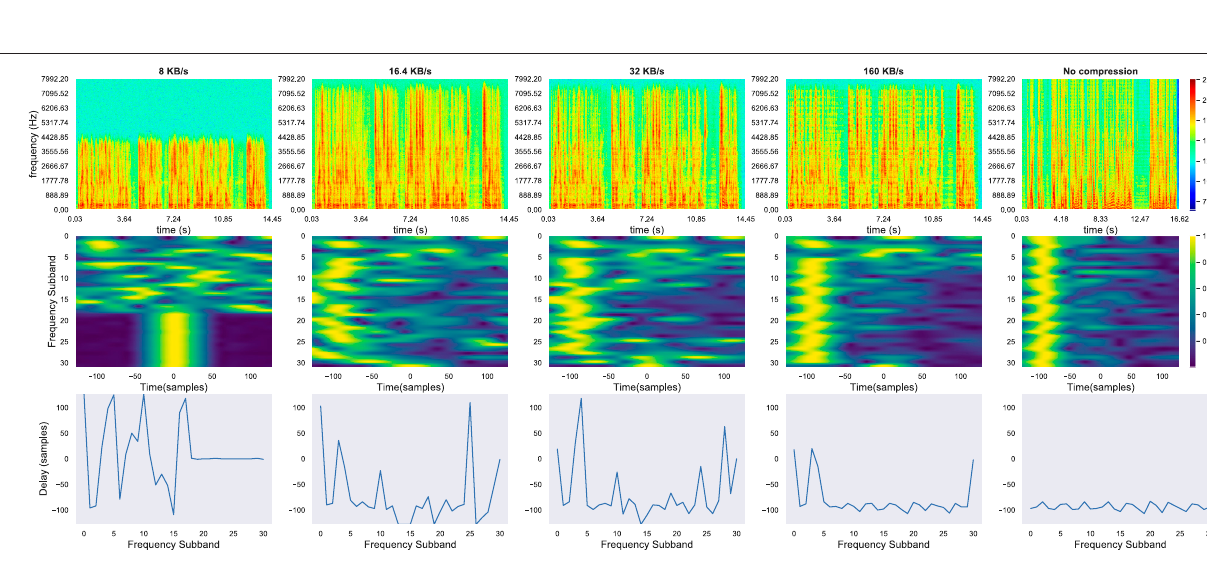
FIGURE 10 | 1 st row: Spectrograms for one uncompressed test utterance channel and its Opus-encoded versions at various bitrates [160, 32, 16.4, 8]kB/s. 2 nd row:Frequency-slidedCPSinputfeaturecomputedbetweentwosegmentsoftheencodedchannels.3 rd row:argumentofthemaximumofCPSineachfrequencyband corresponding to the delay (samples) between the two